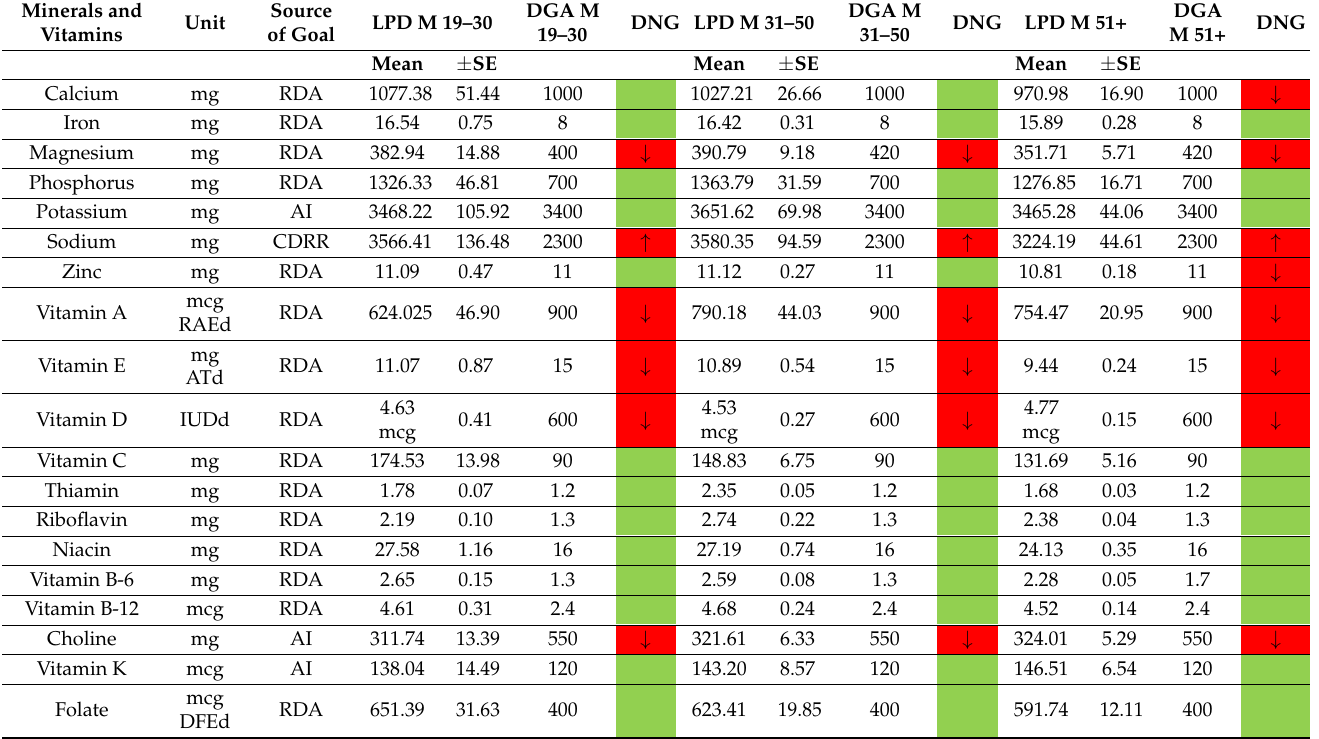
Table 6. Mineral and vitamin intake in males following an LPD compared to the DNG in the 2020–2025 DGA stratified by age